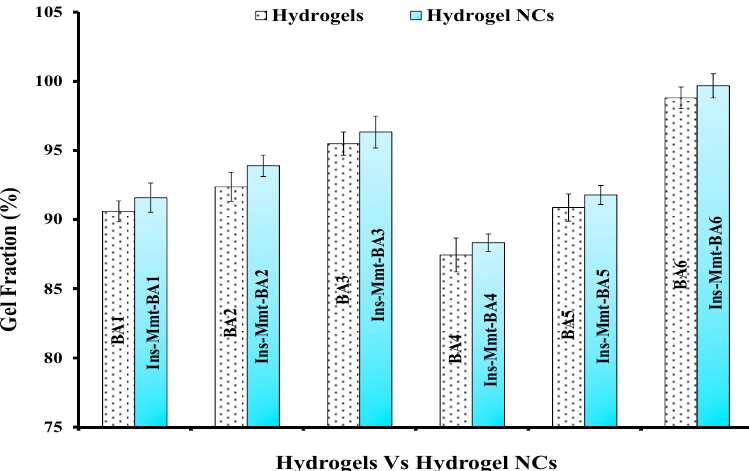
Figure 3. Gel fraction (%) of hydrogels (BA1-BA6) and hydrogel NCs (Ins-Mmt-BA1 to Ins-Mmt- BA6).